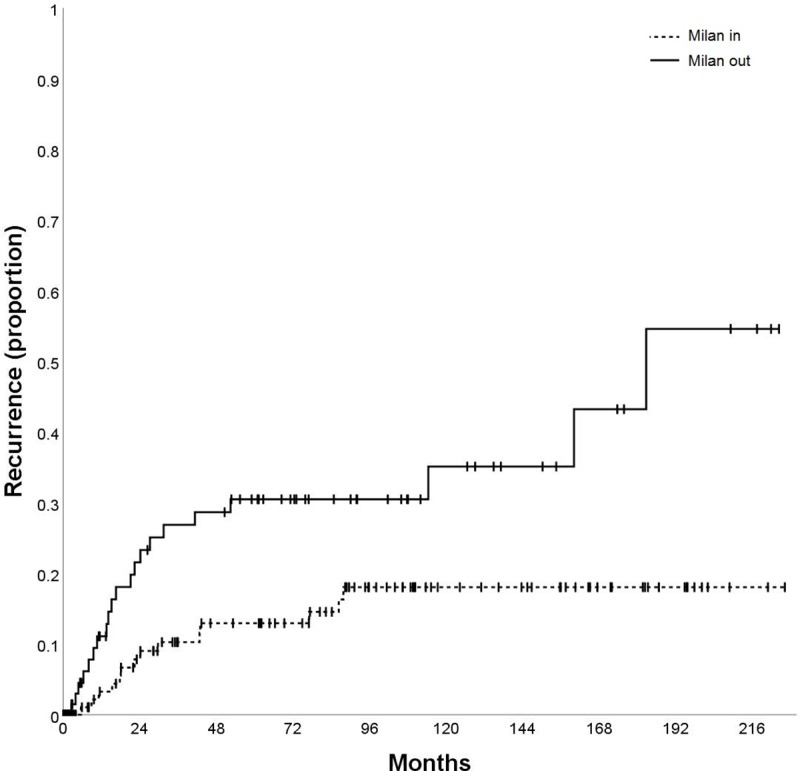
Time to recurrence (TTR) according to Milan status.